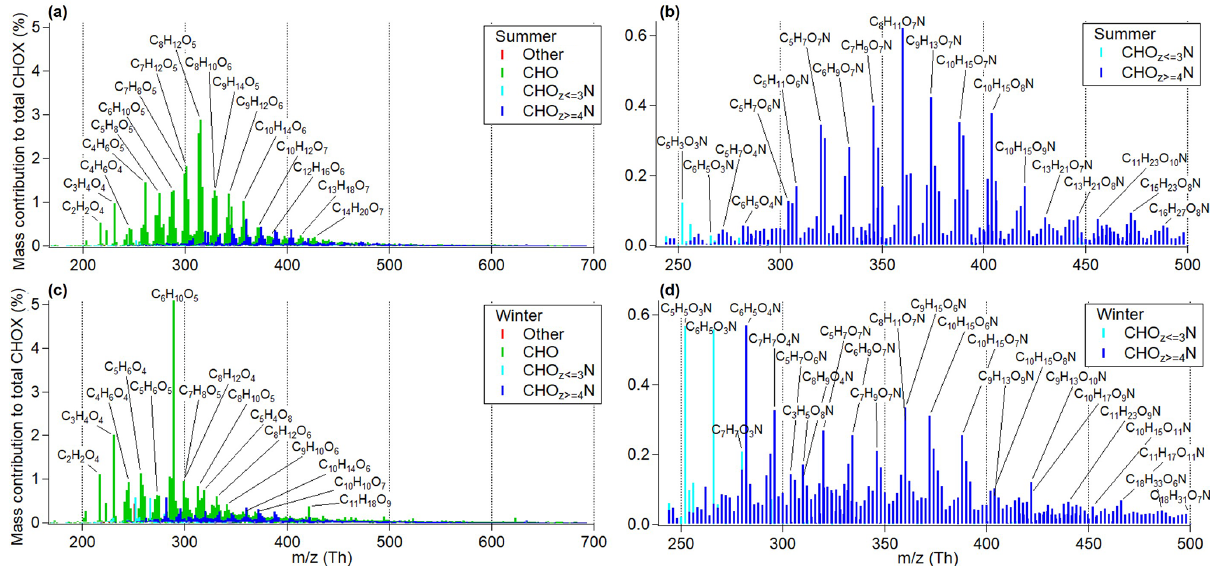
Figure 1. CIMS mass spectra comparison of CHOX compounds (separated into CHO, CHON and other compounds) (a) and CHON com- pounds (b) in the summer period, as well as CHOX compounds (c) and CHON compounds (d) in the winter period as a function of m/z (includes mass of I − ion; m/z 126.9050Th). Mass contributions of each compound were normalized to the sum of the mass of all detected CHOX